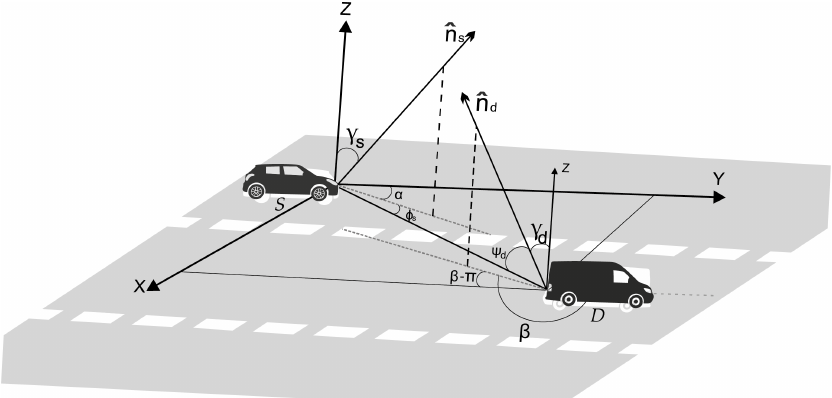
Figure 2. 3D graphical representation of two cars S and D using V2V-VLC along a three-lane roadway. γ s and γ d represent the vertical tilt angles of the LED and PD, respectively, whereas φ s corresponds to the irradiance angle with respect to ˆ n s . α and β denote the horizontal tilt angles with respect to ˆ n s and ˆ n d , respectively. ψ d indicates the incidence angle with respect to ˆ n d . The unitary vectors ˆ n s and ˆ n d are used to denote the transmitter (LED) and receiver (PD) axes; i.e., they are normal to the corresponding